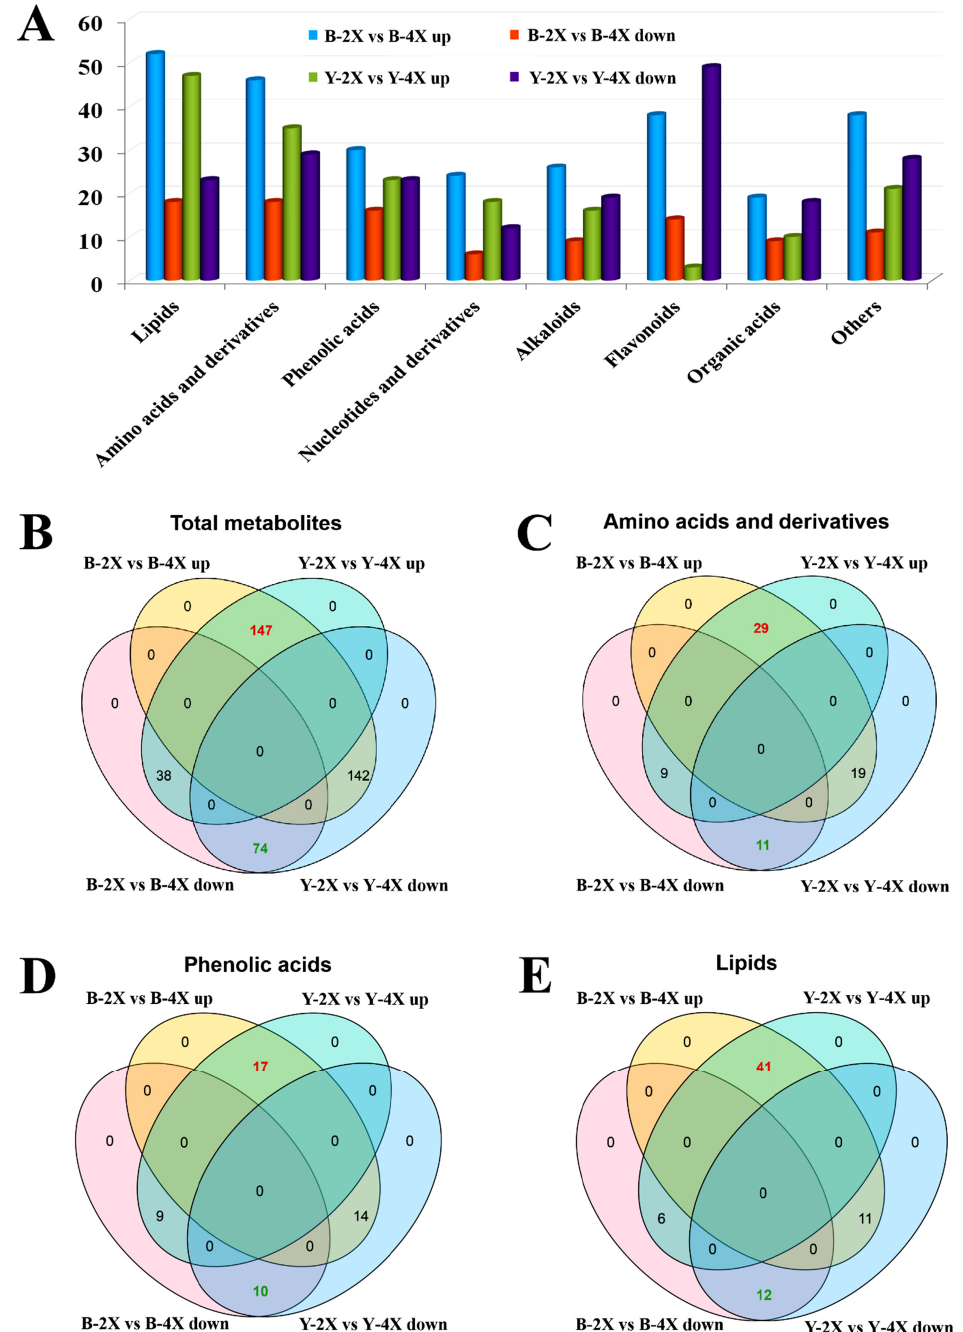
Figure 4. Number of different types of differential metabolites for diploid vs. tetraploid groups. ( A ) Number of different types of differential metabolites for diploid vs. tetraploid. Blue color indicates the number of higher-abundance metabolites of Balilla-2 x vs. Balilla-4 x , and orange color indicates the number of lower-abundance metabolites. Green color indicates the number of higher- abundance metabolites of Yangdao 6-2 x vs. Yangdao 6-4 x , and purple indicates the number of lower-abundance metabolites. ( B – E ) Comparison of expression trends of differential metabolites for diploid vs. tetraploid between japonica and indica groups. ( B ) Total metabolites, ( C ) amino acids and derivatives, ( D ) phenolic acids, ( E )